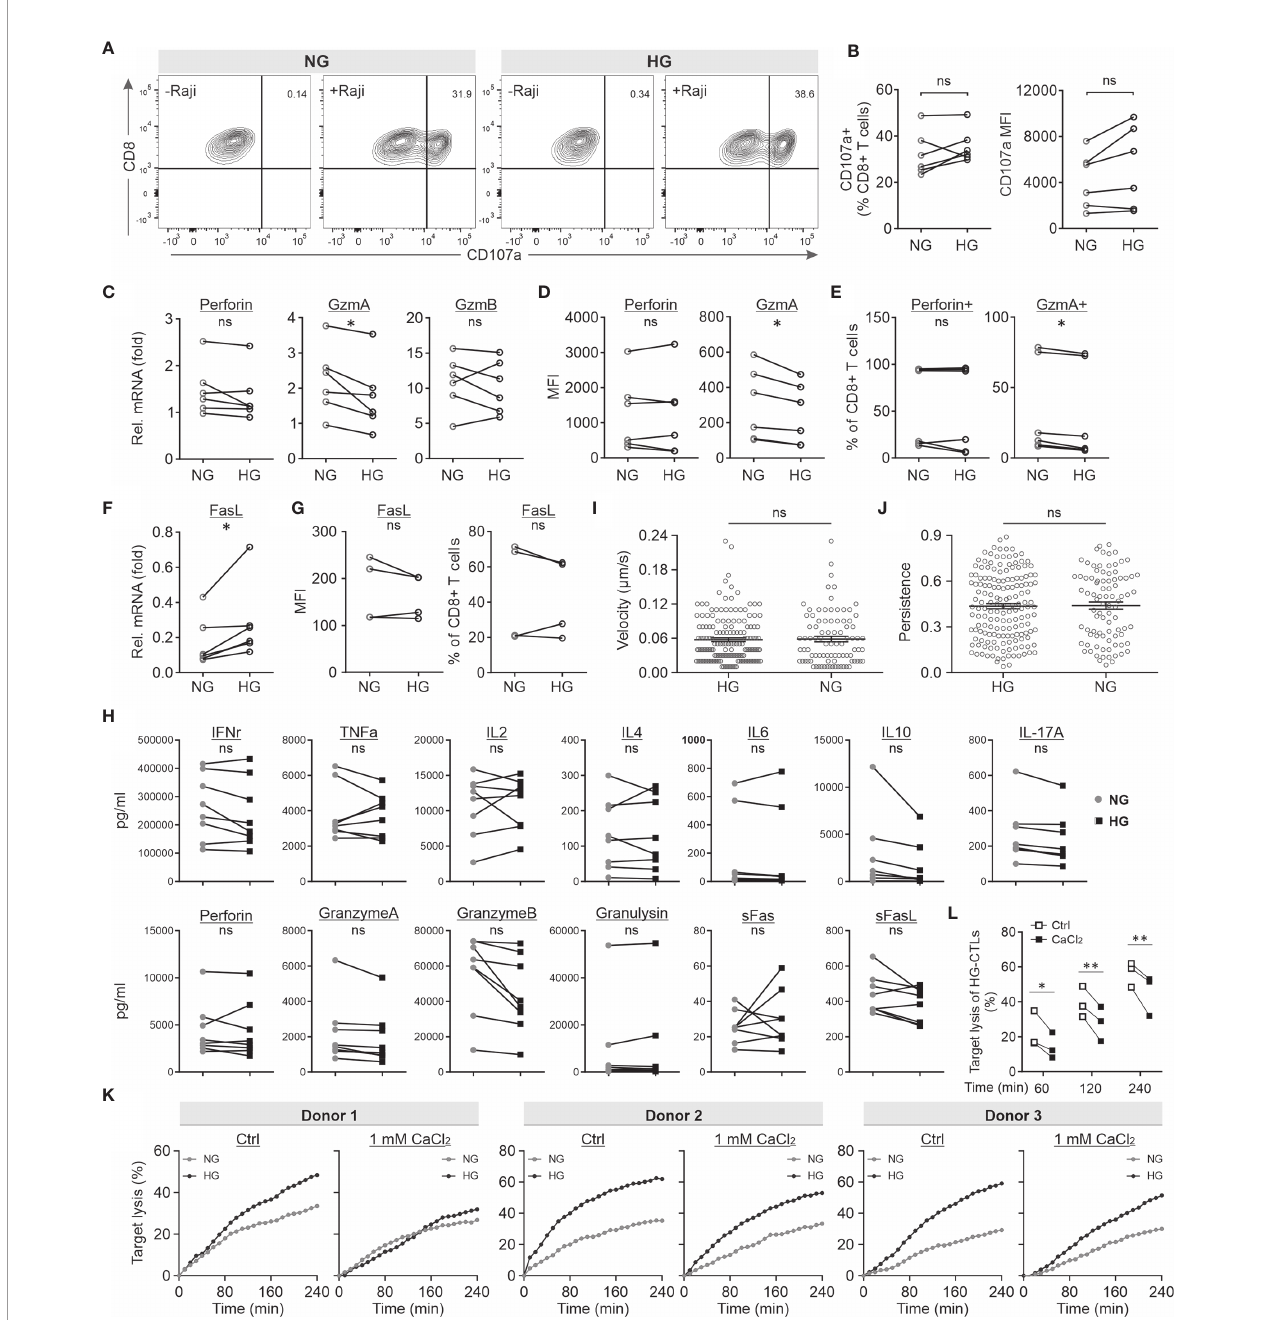
FIGURE 4 | HG-enhanced CTL killing function is regulated by extracellular Ca 2+ . (A, B) Degranulation of lytic granules is not in fl uenced by HG. CD 107a degranulation assay was conducted. Raji cells pulsed with SEA/SEB were used as target cells. Results are from six donors. (C) The mRNA level was determined by quantitative PCR using TBP and RNA polymerase as internal controls. Results are from six donors. (D, E) The protein level was determined using fl ow cytometry. Mean fl uorescence intensity (MFI, D ) and the positive fraction of CTLs (E) are shown. Results are from six donors. (F, G) Expression level of FasL at mRNA level (F) and at protein level (G) . (H) Release of cytokines and cytotoxic proteins. Multiplex cytokine assay was performed to determine the concentration of the analytes. Results are from eight donors. (I, J) Migration of CTLs is not altered in HG-cultured CTLs. Migration of CTLs was visualized using light-sheet microscopy. Velocity (I) and persistence (J) were analyzed using Imaris. Results are from two independent experiments and from two donors (88 cells for HG and 162 cells for NG). (K, L) Addition of extracellular Ca 2+ diminishes HG-enhanced CTL killing ef fi ciency. Bead-stimulated primary CD8 + T cells and SEA/SEB-pulsed Raji cells were used for the real-time killing assay with addition of CaCl 2 (1 mM). Target lysis of HG-CTLs at 60, 120 and 240 min were extracted from the kinetics and shown in (L) . Results are from two independent experiments and from three donors. * p < 0.05; ** p < 0.01; ns, not signi fi